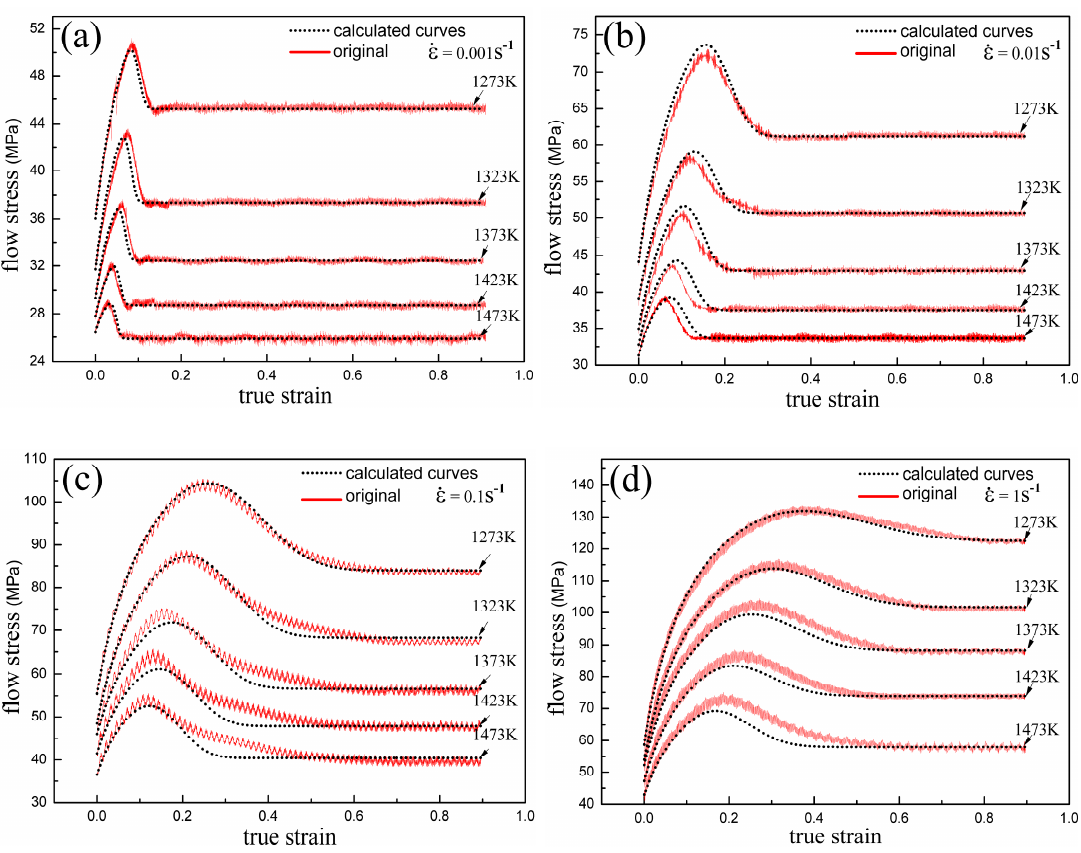
Figure 12. Original true stress-strain curves and calculated flow stress curves considering eDRV and DRX processes of Armco-type pure iron: ( a ) s -1 . The red solid curves are the original true stress-strain curves while the dot lines are the flow stress curves calculated through Equation (23).